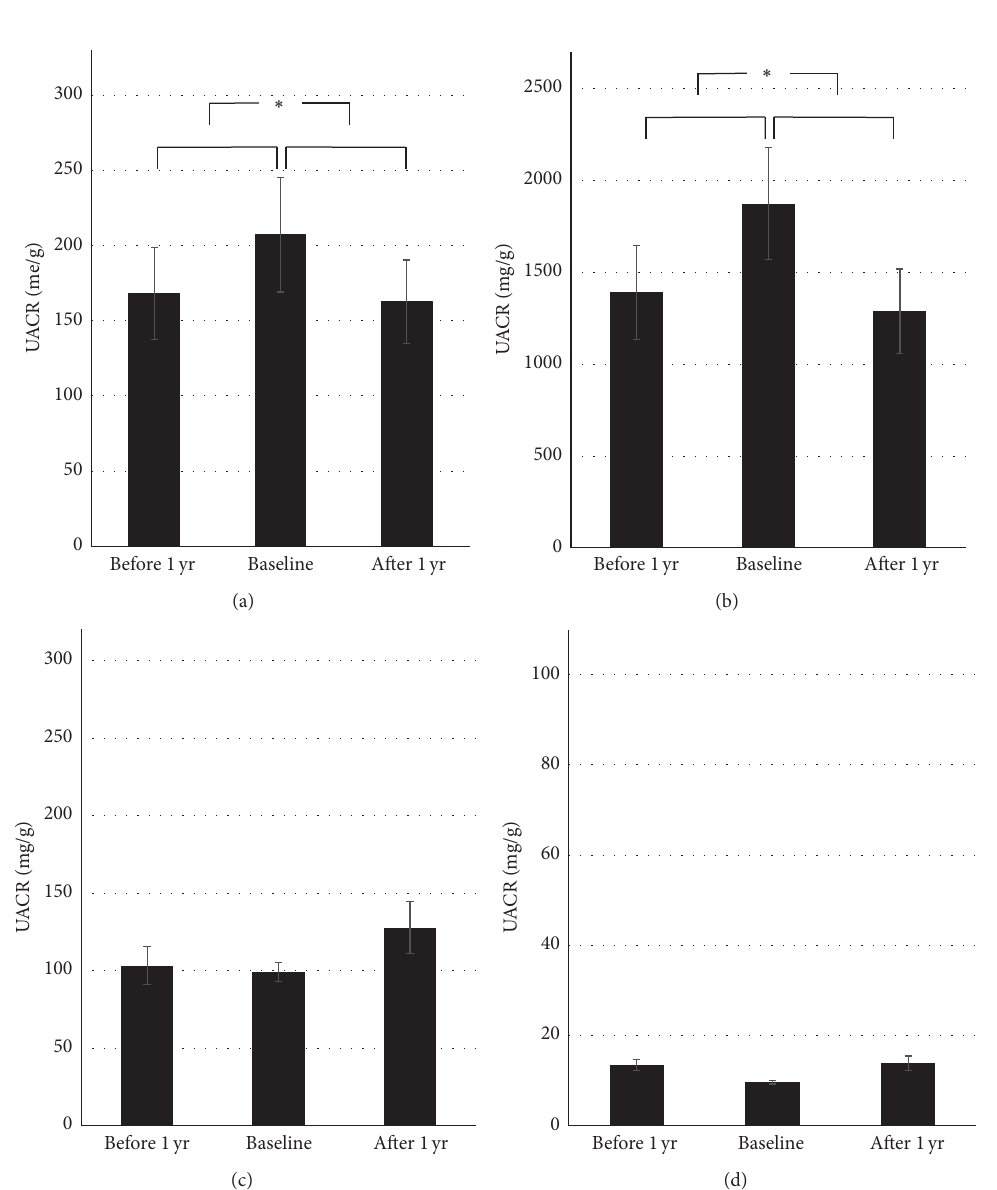
Figure 1: Changes in urine albumin/creatinine ratio 1 year before and 1 year after DPP-4i treatment initiation. Changes in urine albumin/creatinine ratio in all patients (a) and in patients with macroalbuminuria (b), microalbuminuria (c), and normoalbuminuria (d). (Data are presented as means with standard errors.) DPP-4i: dipeptidyl-peptidase IV inhibitor; UACR: urine albumin/creatinine ratio. ∗ 𝑝 value <